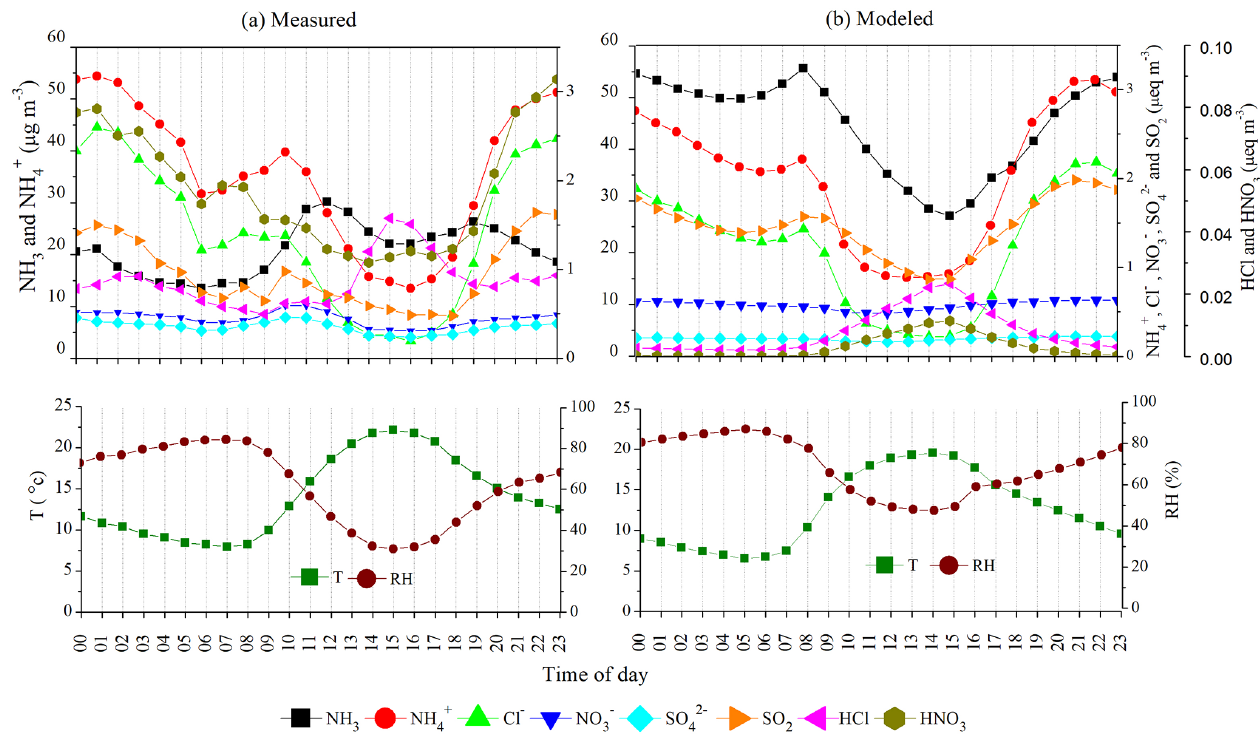
+ concentration (µgm − 3 ) with mole equivalents of Cl − , NO − 4